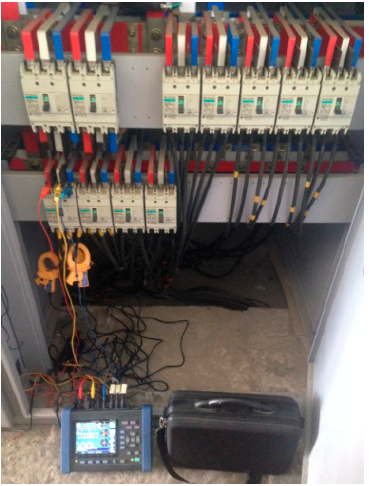
Figure 1. Actual wiring diagram of the charging station.